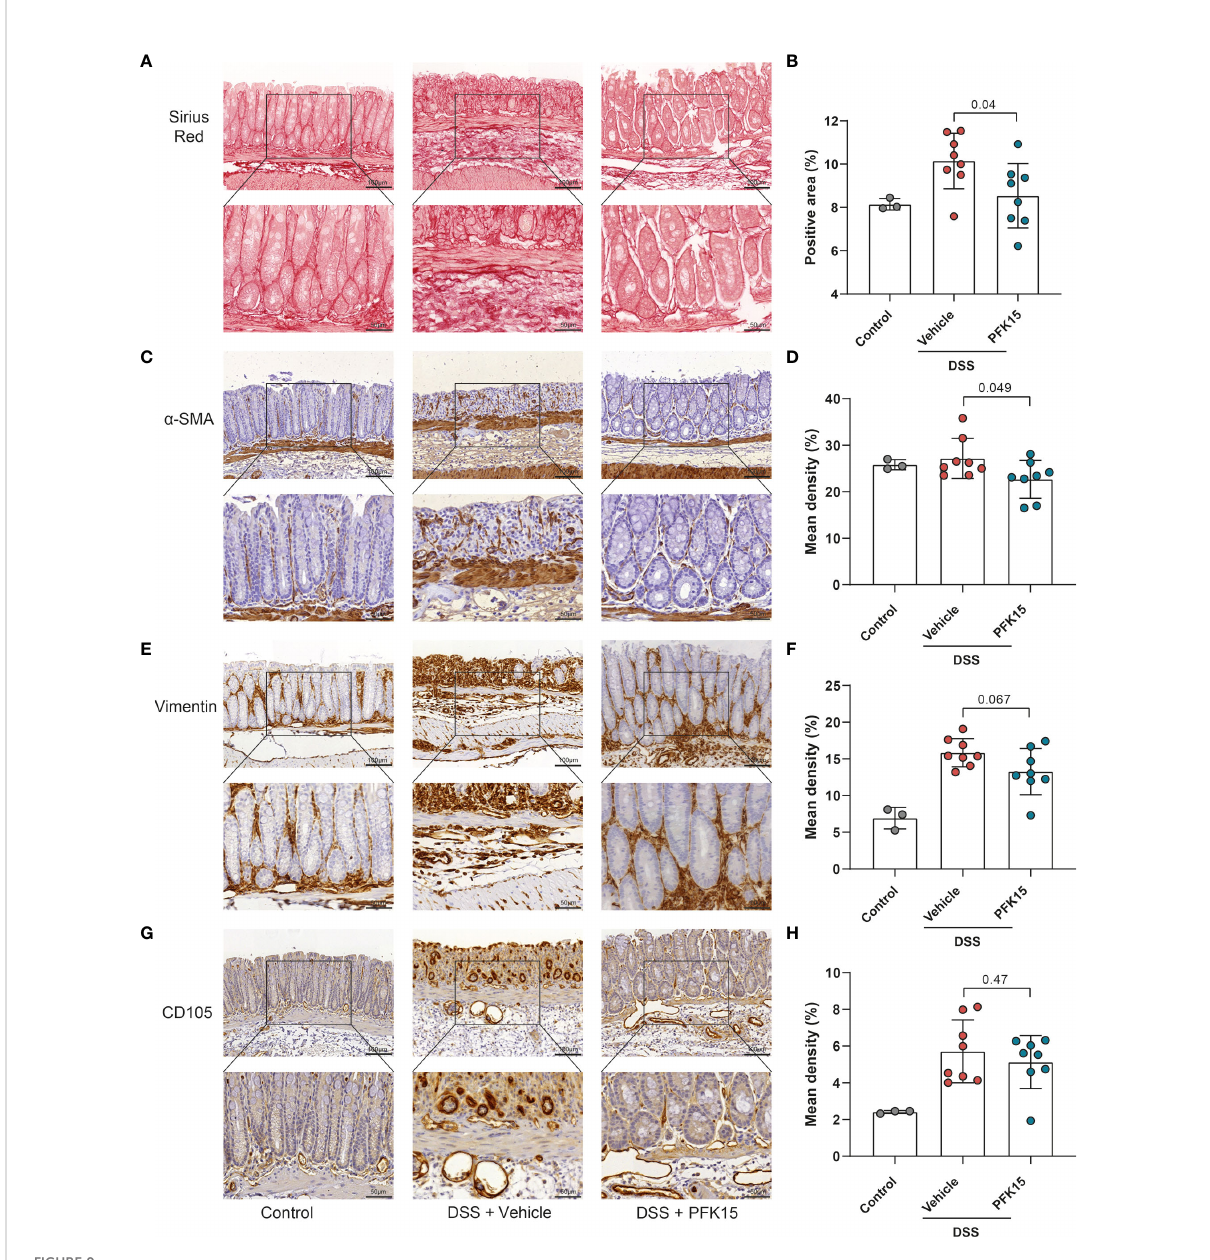
FIGURE 9 Inhibition of PFKFB3 decreased the stromal activation in DSS-induced colitis. (A) Representative image from Sirius red staining of the colon. (B) Quanti fi cation analysis, based on the percentage of the positively stained area. Representative images for staining of a -SMA (C) , vimentin (E) , and CD105 (G) with quanti fi cation analysis, based on the percentage of positively stained area in the total area (D, F, H) . Unpaired two-tailed t-test was performed to assess statistical signi fi cance between vehicle treated and PFK15 treated mice. Scale bar, 100 m m (upper panel) or 50 m m (lower